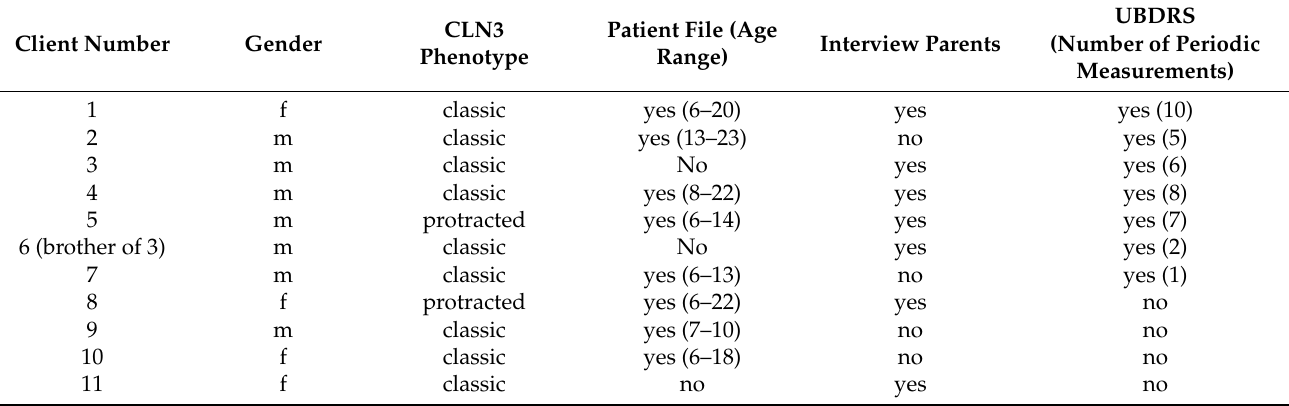
Table 1. Available data per